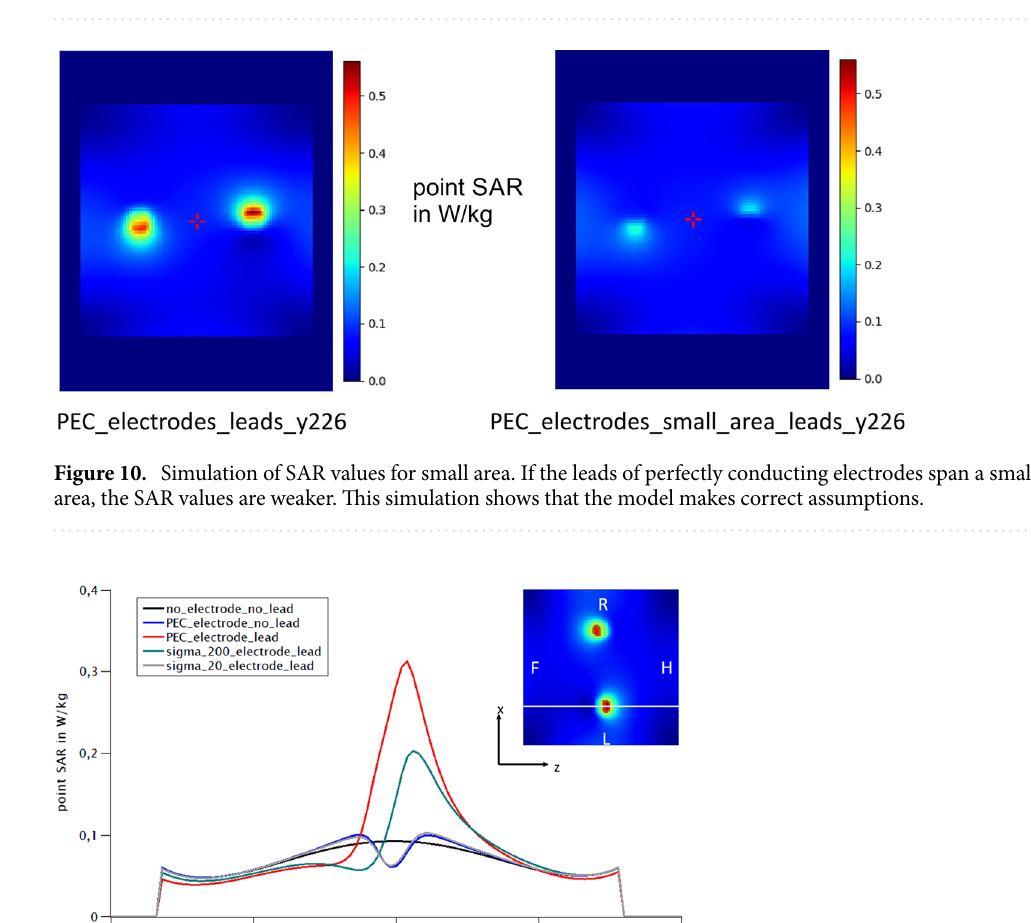
Figure 9. Simulation of SAR values, effect of insulation layer. The insulation layer blocks SAR values in the z-plane (right). The insulation layer weakens SAR values of a perfectly conducting electrode (left with insulation layer, middle without insulation layer).